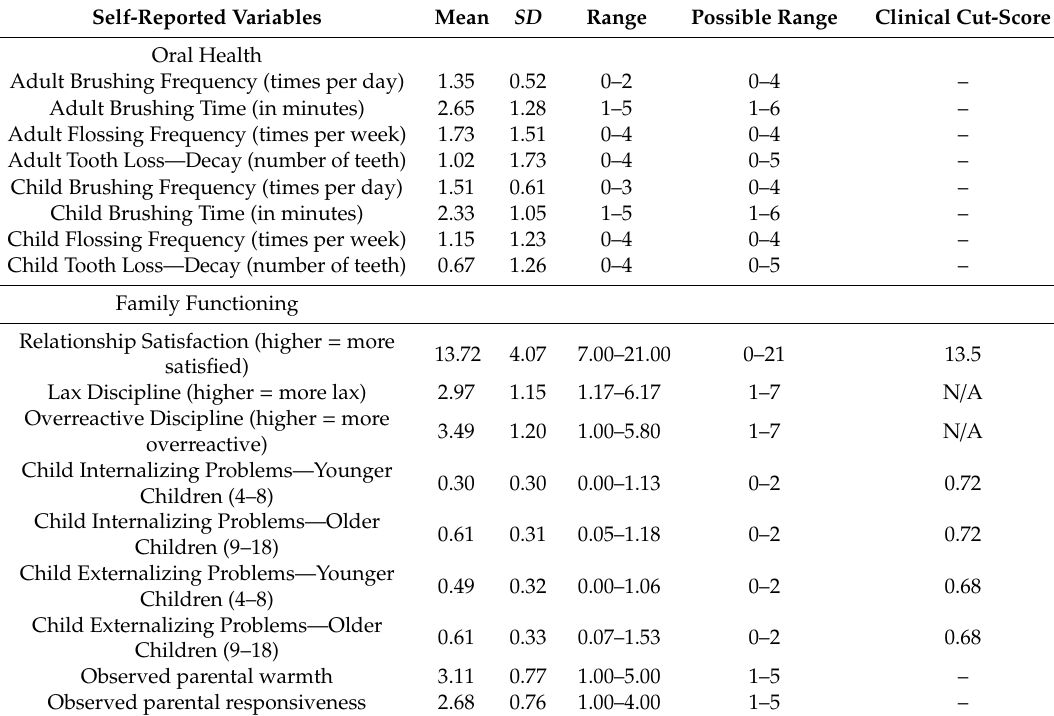
Table 2. Descriptive Statistics for Study 2